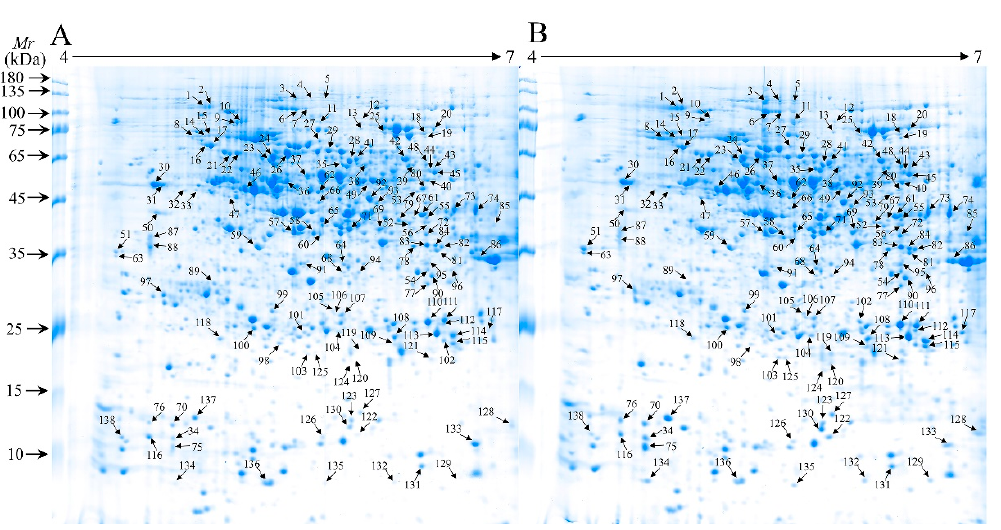
Figure 5. Two-dimensional gel electrophoresis (2-DE) image analysis of proteomes in control and WV treated wheat roots. ( A ) control group; ( B ) WV treated group (1:900).